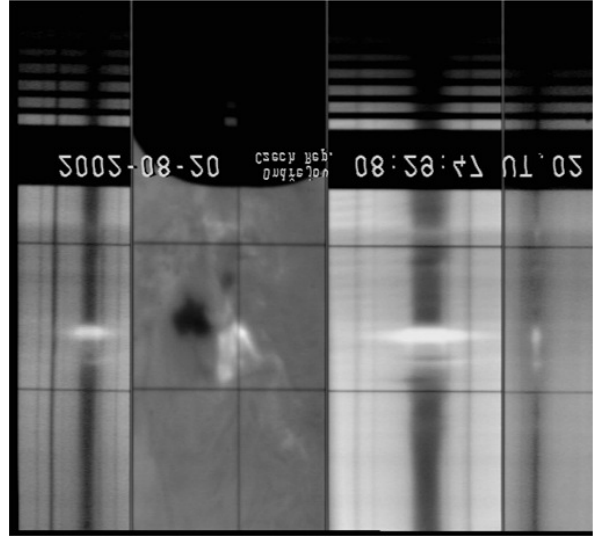
Figure 3. The image from MFS shows the flash spectra in lines: H β , H α , CaIR. The position of the spectrograph slit is marked in the H α (SJ) line in the filtergram. At the top of the image is a stepped attenuator.